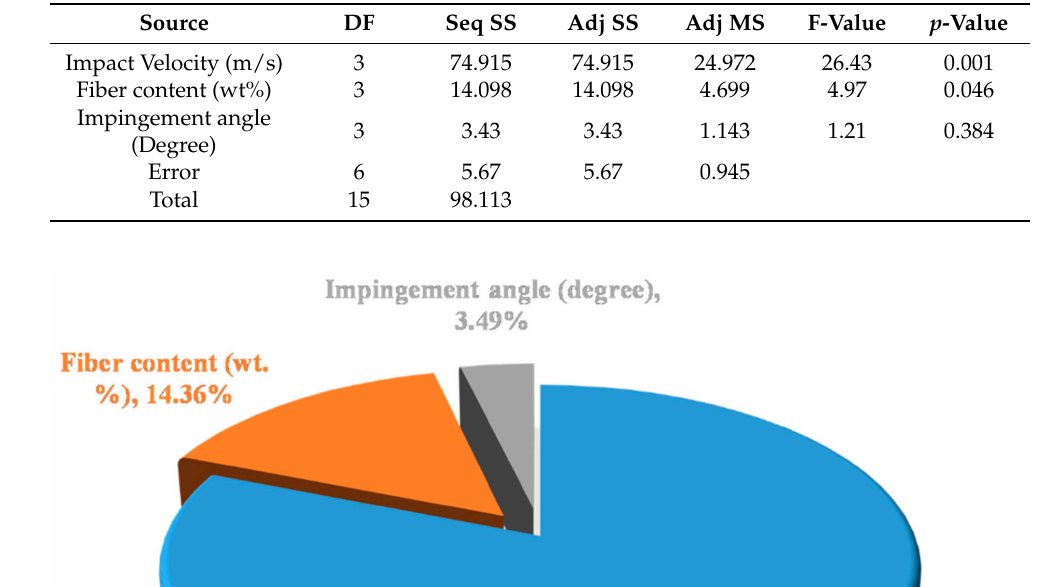
Table 8. Analysis of variance for SNRA2, using adjusted SS for tests epoxy-based composites.